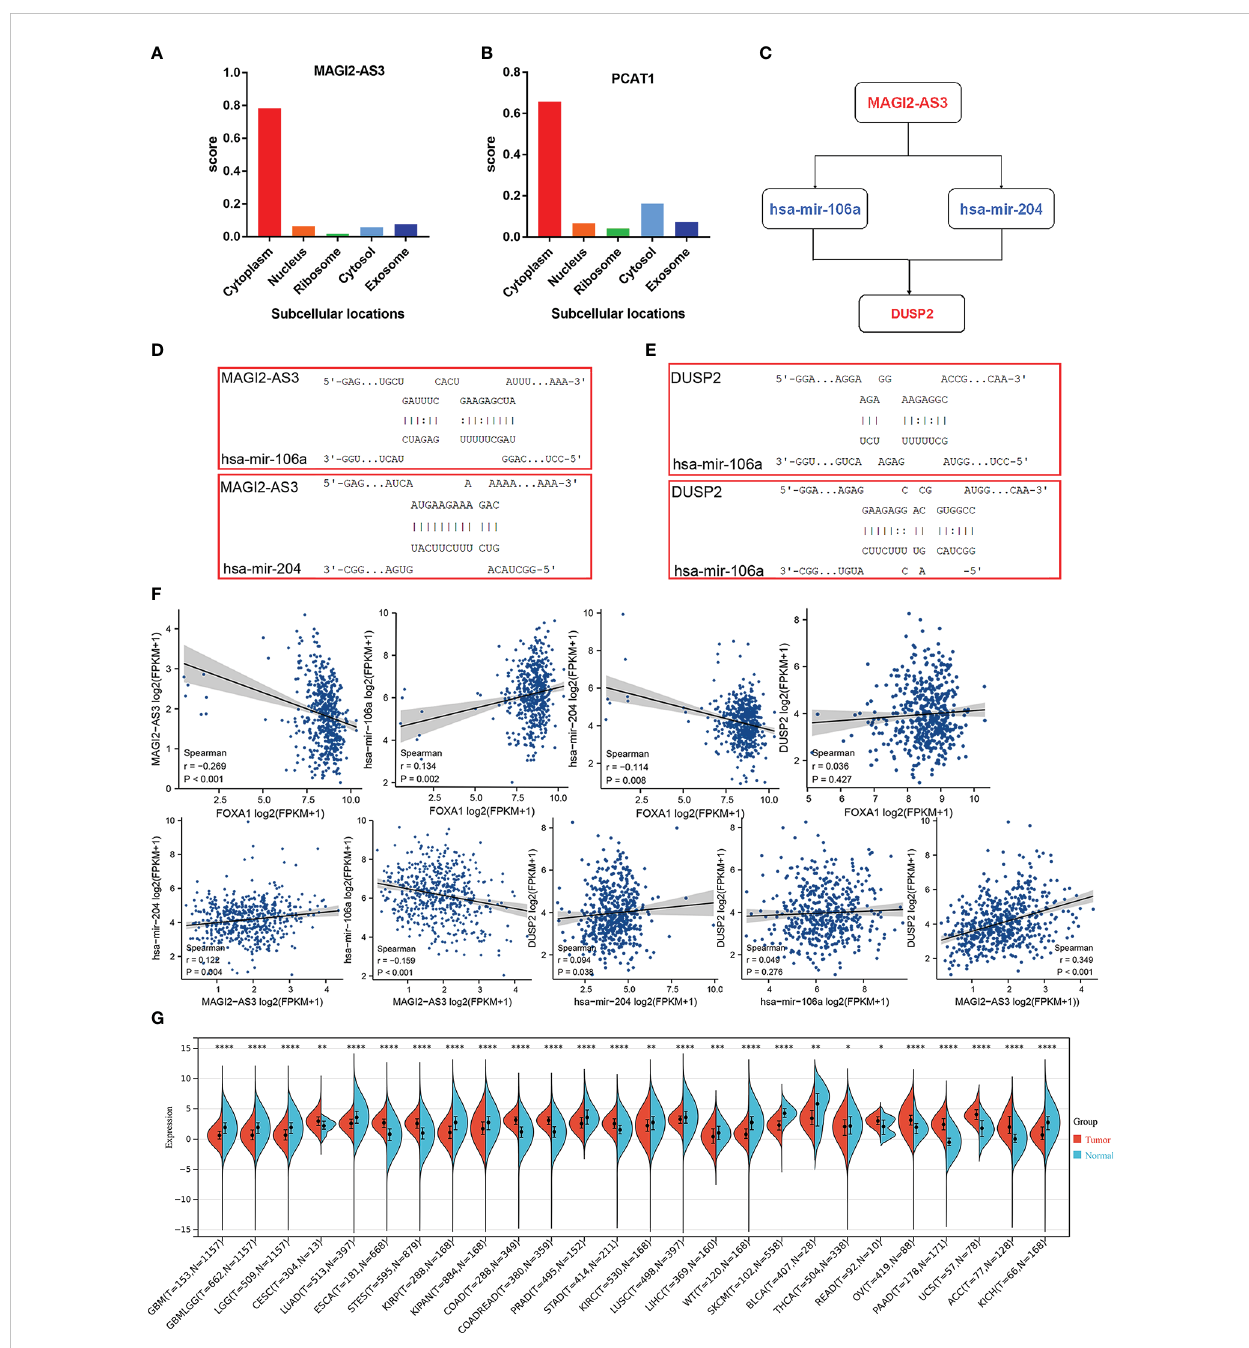
FIGURE 6 Construction and veri fi cation of the ceRNA network. (A, B) The cellular localization for two hub-lncRNAs (MAGI2-AS3 and PCAT1) was predicted using lncLocator. (C) Schematic model of ceRNA. Blue indicates upregulated; red indicates downregulated. (D, E) Base pairing between has-mir- 106a and has-mir-204 and the target site in the MAGI2-AS3 and DUSP2 3 ’ UTR predicted by RNAInter, respectively. (F) Correlation analysis between these four predictive RNAs and FOXA1 in PCa. (G) Expression distribution of DUSP2 in pan-cancer tissues. *P <0.05, **P < 0.01, ***P < 0.001,